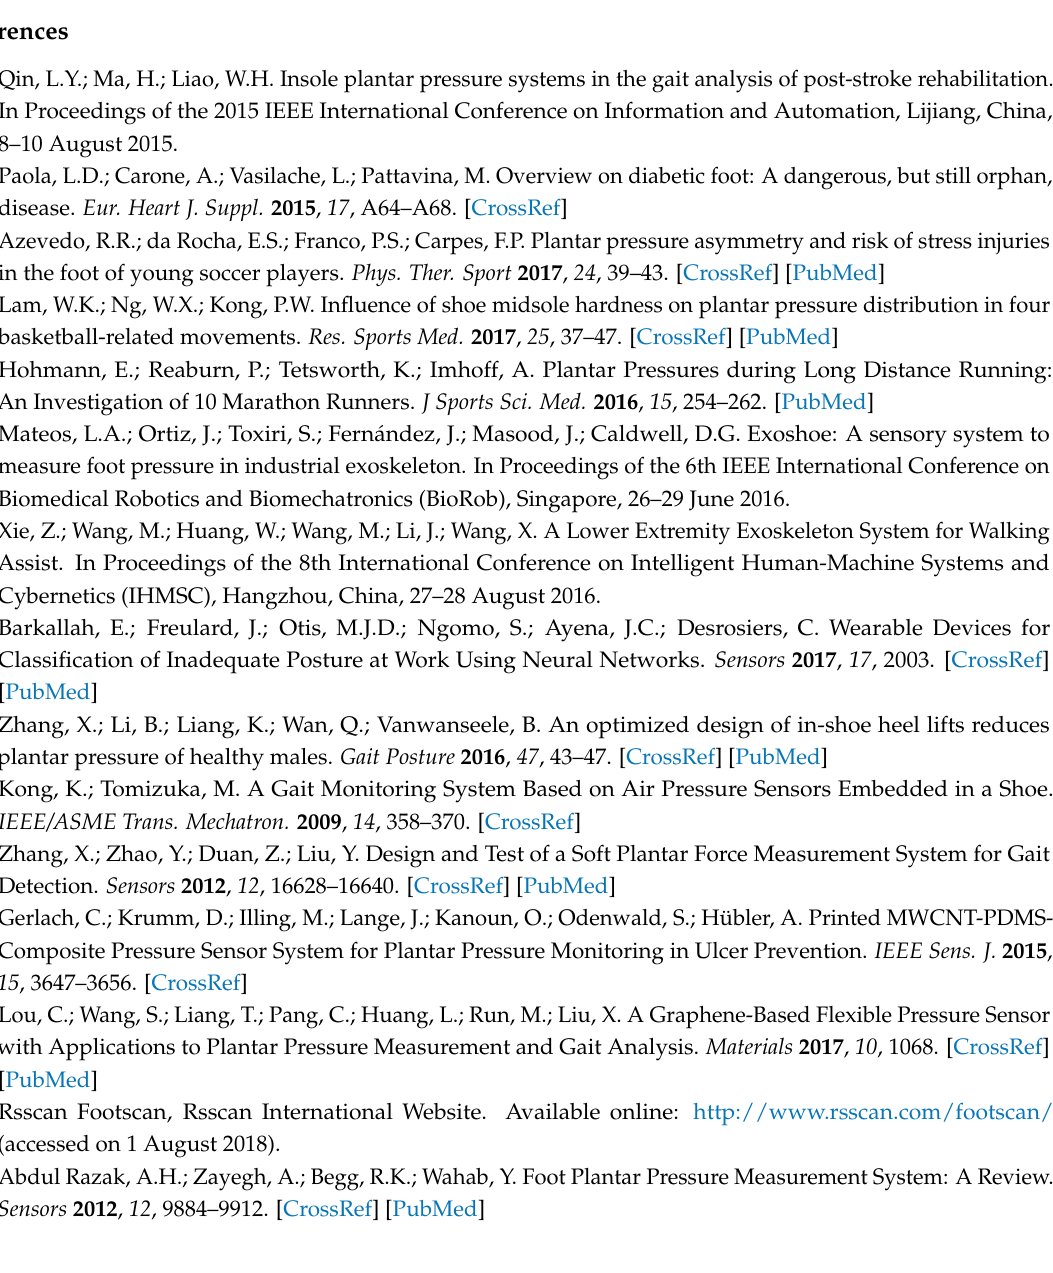
Figure S1: Calibration curves for all sensing